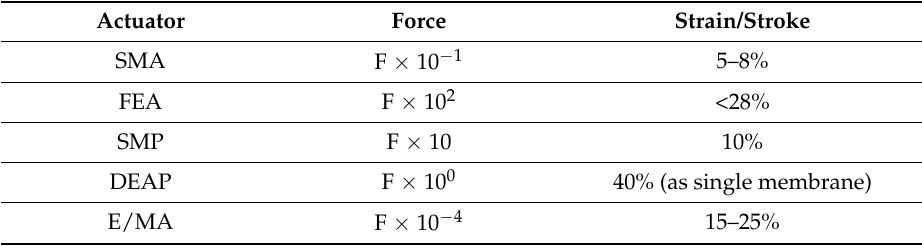
Table 3. Evaluation of soft/novel actuators according to operation range (Section